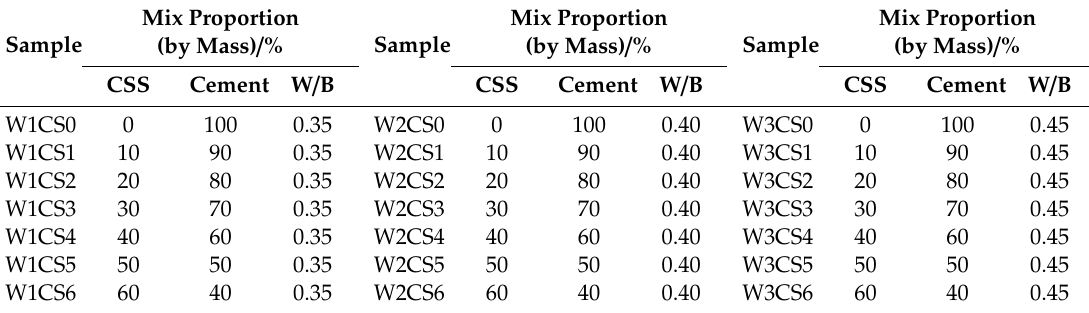
Table 2. Paste samples containing CSS and